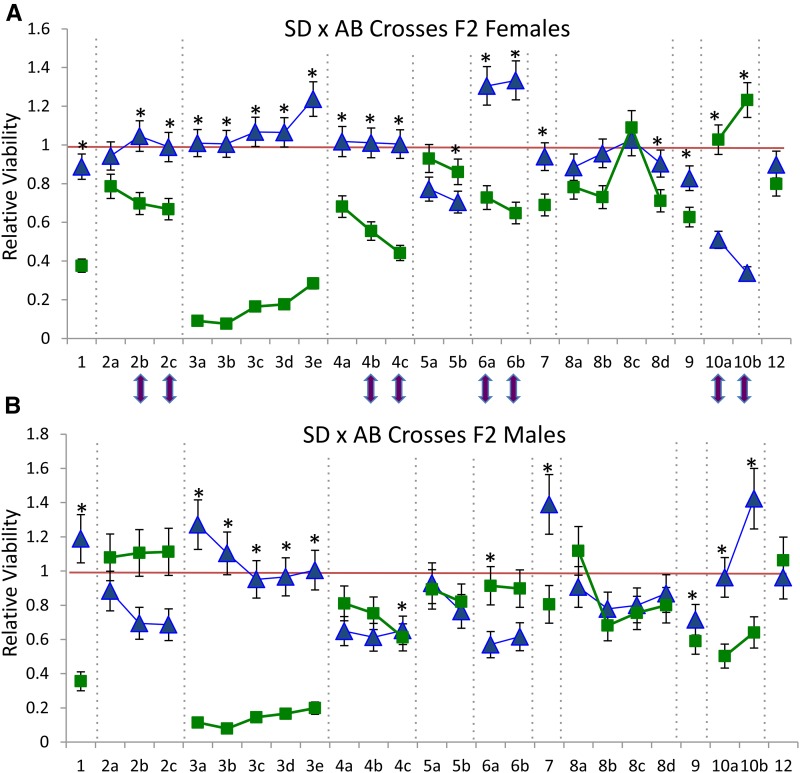
Sex impacts on relative viabilities of genotypes across iPlex markers in AB × SD F2 hybrids of T. californicus. Panel (A) gives the relative viabilities for all F2 females, while (B) gives the relative viabilities of all F2 males. Blue triangles give the relative viabilities of the AB/AB homozygous genotypic class, while green squares give the relative viabilities for the SD/SD homozygous genotypic class. The red line indicates the expected relative viability of one for each homozygote genotypic class. An asterisk indicates a marker where genotypes differ significantly from the expected 1:2:1 ratio (P < 0.002 corrected P-value after applying a Bonferroni correction for 25 tests with α = 0.05 and 2 d.f.). Purple arrows show the markers for which there is a significant difference between the two sexes for genotypic ratios. This was tested in a 2 by 3 contingency table analysis with a critical P-value again of 0.002.